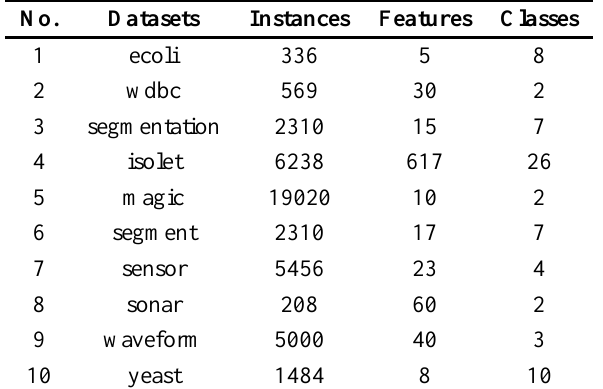
Table 1. The description of 10 datasets in our